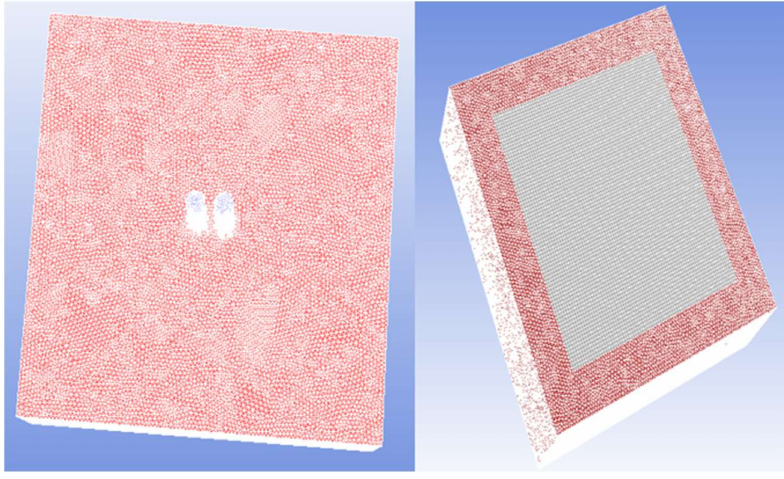
Figure 5. Tetrahedral mesh